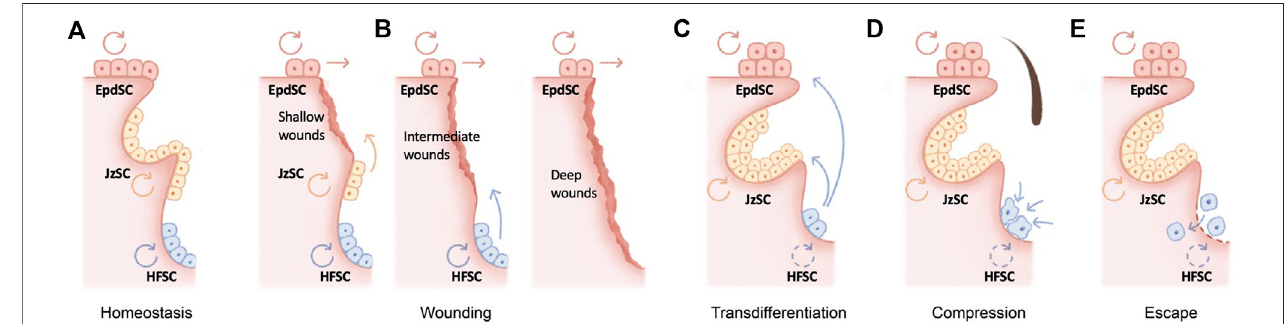
FIGURE 1 | Molecular mechanisms underlying hair follicle miniaturization in aging (A) The hair follicle as a major skin appendage is maintained by hair follicle stem cells (HFSCs) residing in the bulge, an anatomic location beneath the sebaceous gland and isthmus of the pilosebaceous unit. HFSCs fuel the cyclic regeneration ofhair follicles during homeostatic hair growth, whereas epidermal stem cells (EpdSC) and junctional zone stem cells (JzSCs) maintain the epidermis and junctional zone, respectively (B) HFSCsdrivebothfollicularandepidermalregenerationduringwoundrepair.Dependingonthewoundingdepth,differentpopulationsofstemcells are induced to contribute to wound repair (C – E) Several cellular and molecular mechanisms have been recently proposed to explain the fate of aging HFSCs in murine models, including epidermal transdifferentiation (C) , mechanical compression in situ (D) , and escape into dermis (E)